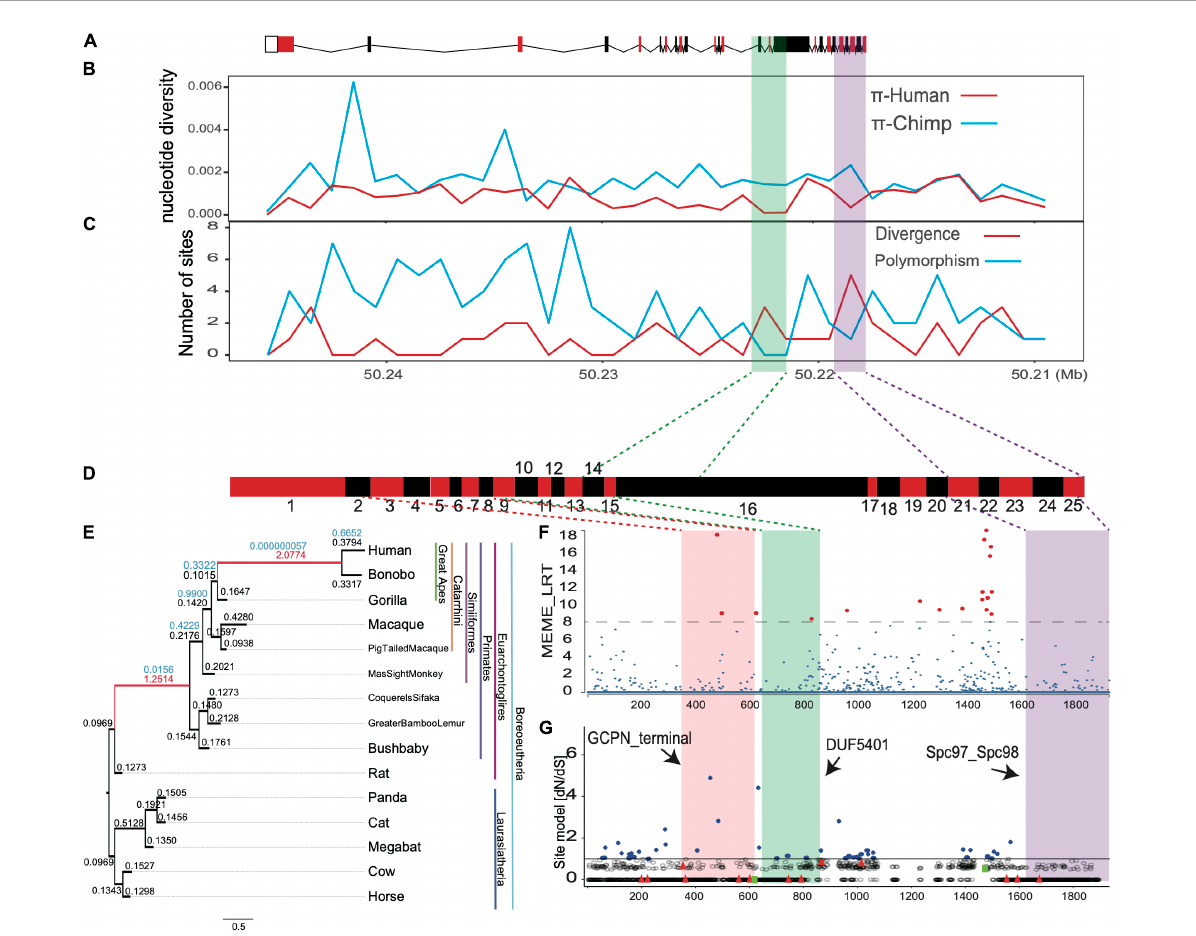
FIGURE5 The positive selection signals for TUBGCP6 based on multiple methods. (A) The gene structure of TUBGCP6 , including exons (boxes) and introns (lines). (B–C) The combined methods of nucleotide diversity ( π ) and the HKA test. (D) The exons (red and black boxes) of TUBGCP6 . (E) The branch model test results based on the comparisons between two-ratio models and one-ratio model. All branches in the phylogeny were used as foreground lineage in an iterative way. The numbers above the ancestral branches showed the dN/dS and significance level. Only the significant branches and dN/dS were shown in red. (F) The MEME method in HyPhy package. The significance level was shown with dotted line and with the consideration of multiple test correction ( p < 0.01). The red points showed the inferred positively selected sites. (G) The potentially positively selected sites (blue, dN/dS > 1) based on the site model test of CODEML (M7 vs. M8). The two green squares represent two variants (Y613* and E1368K). The black arrows indicate the three